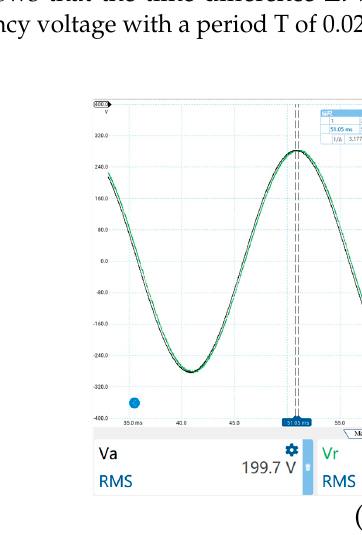
Figure 6 shows the fitting curve and relative error characteristics of the reconstructed voltage and the actual output voltage ε ; it is expressed as: